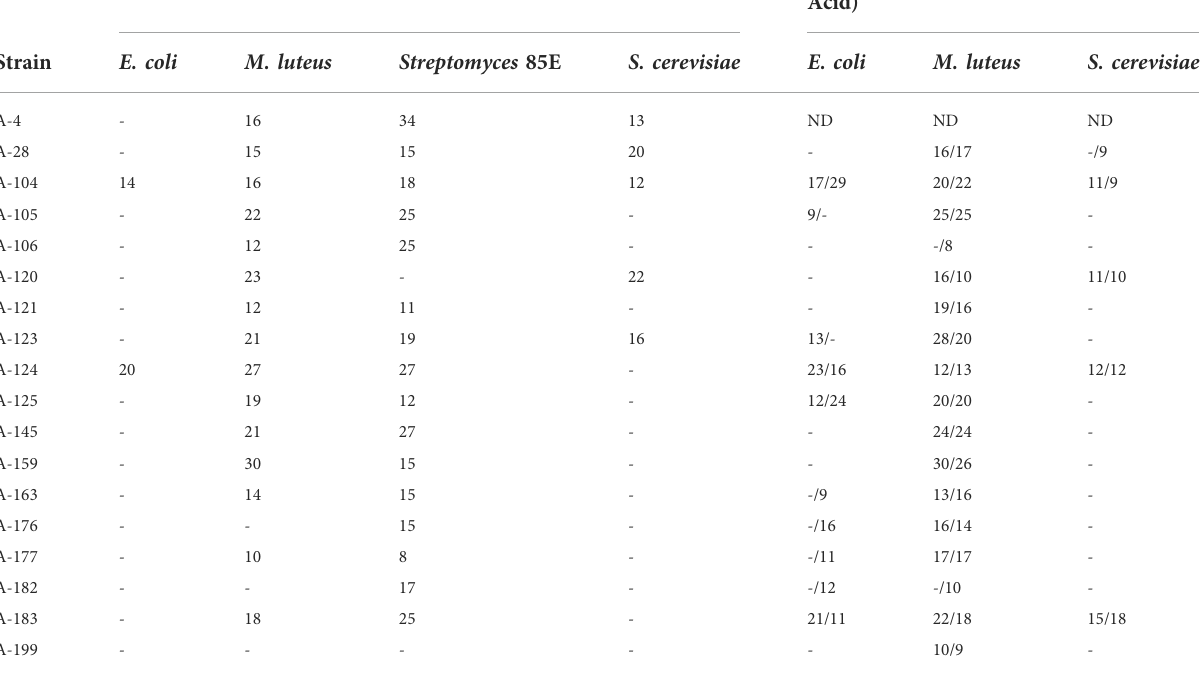
TABLE 1 Antibiotic activities of Actinobacteria against a panel of Gram-negative, Gram-positive bacteria and fungi. A. Agar